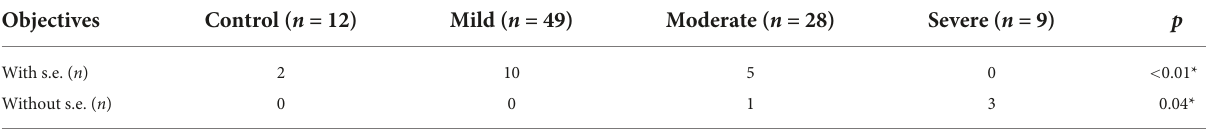
TABLE 4 Characteristics of isolated bacterial flora in control and different MGD severity. Objectives Control ( n =